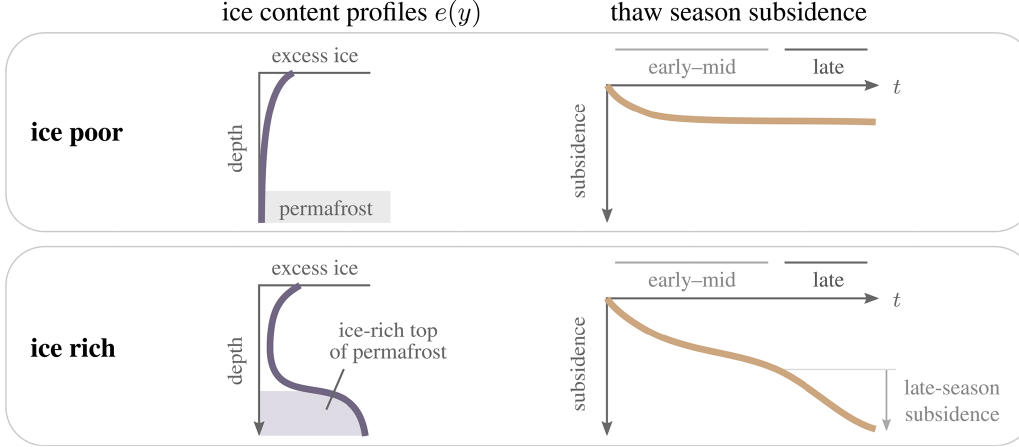
Figure 1. Late-season subsidence is predicted to be closely related to the excess ice content at the top of permafrost in an exceptionally warm (and wet) summer. When the thaw front penetrates the permafrost in the late season, the melt of excess ice in the permafrost, where present, will give rise to increased subsidence. Early-season subsidence reflects excess ice at the top of the active layer, which may also be present in units with ice-poor permafrost (top row), such as young floodplains. The subsidence time series are cumulative and relative to the beginning of the thaw season.